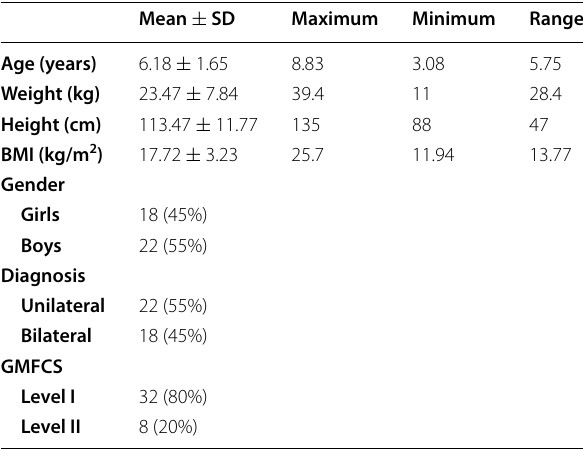
Table 1 Basic characteristics of all participants